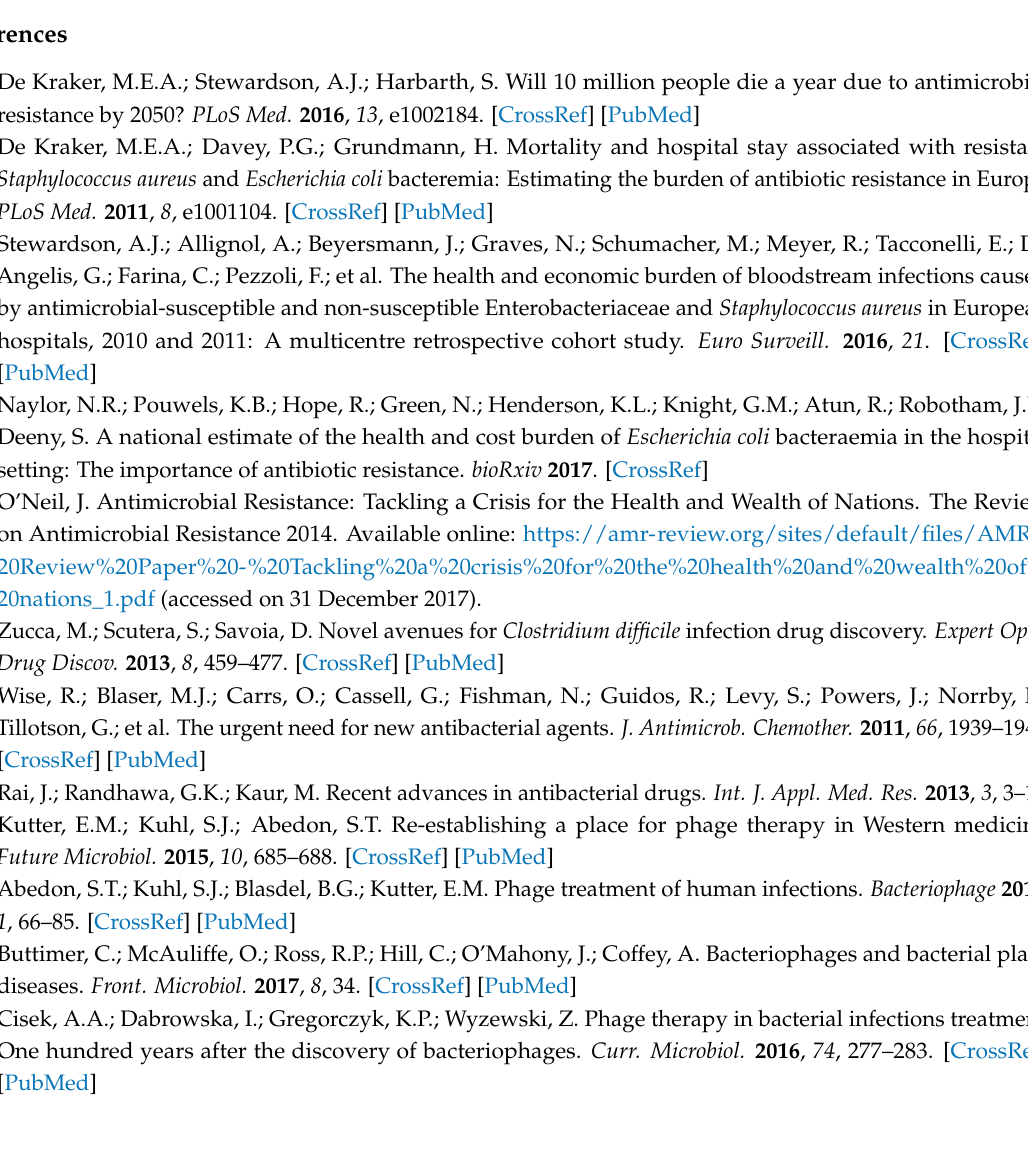
Table S1: Percent bacterial families analysed from the metagenomics data using